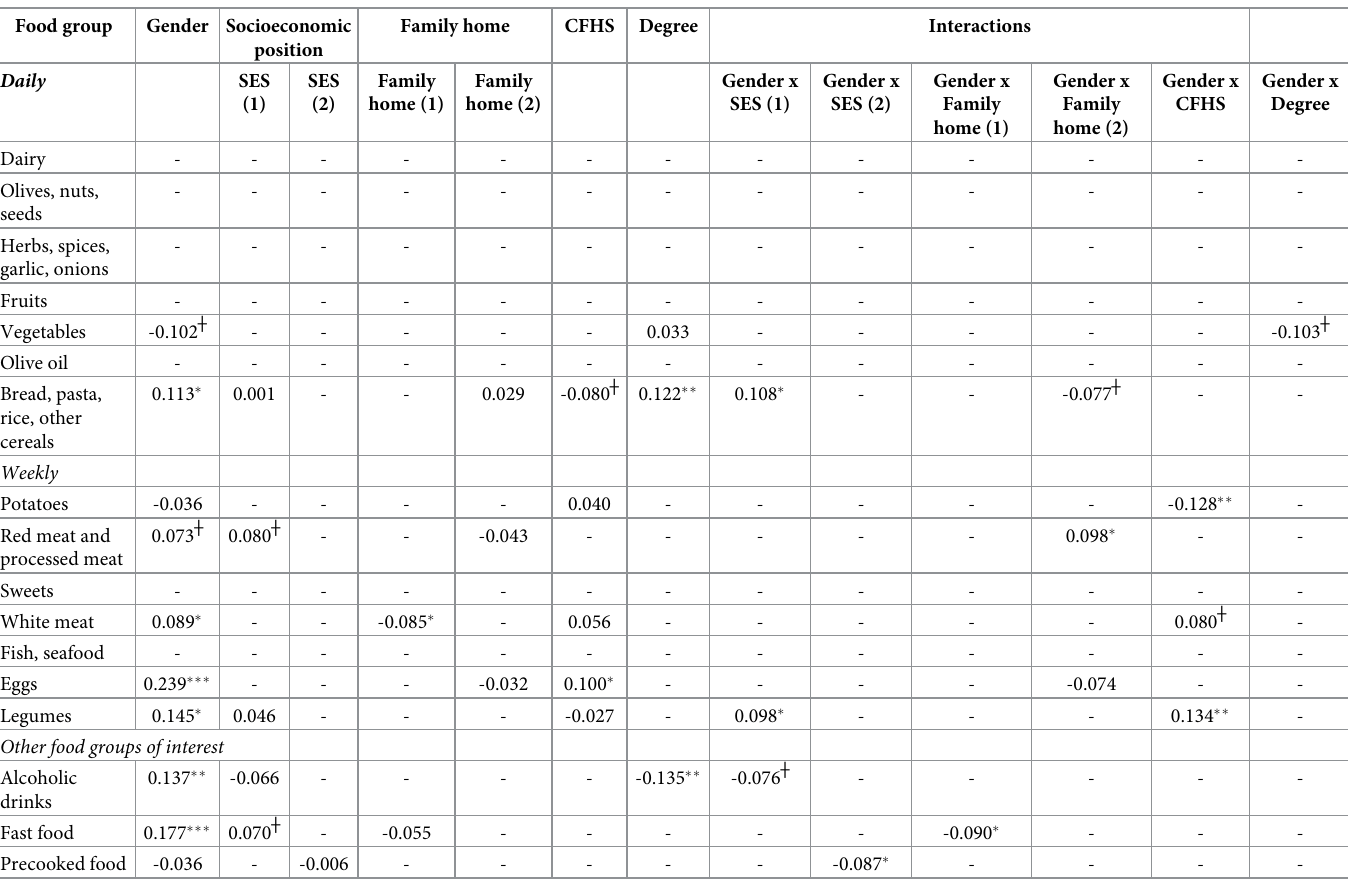
Table 9. Multiple regression analysis: Fitted models for significant